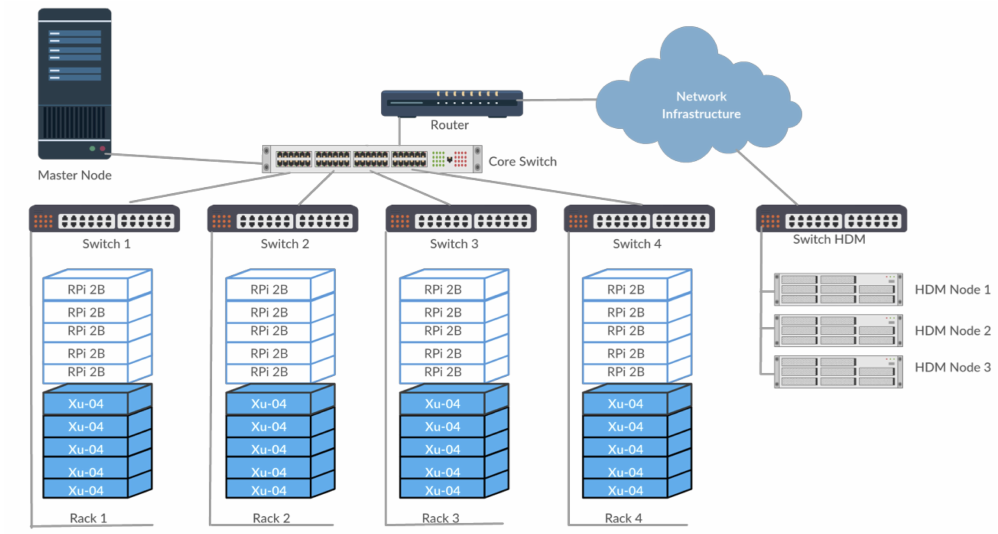
Figure 1. Network topology diagram for RPi, Xu20 and HDM